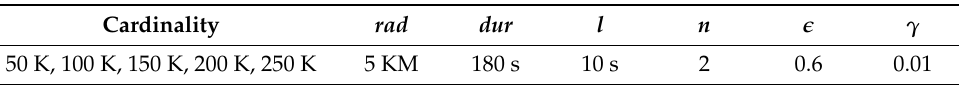
Table 8. Setting of synthetic data parameters and algorithm parameters on real data